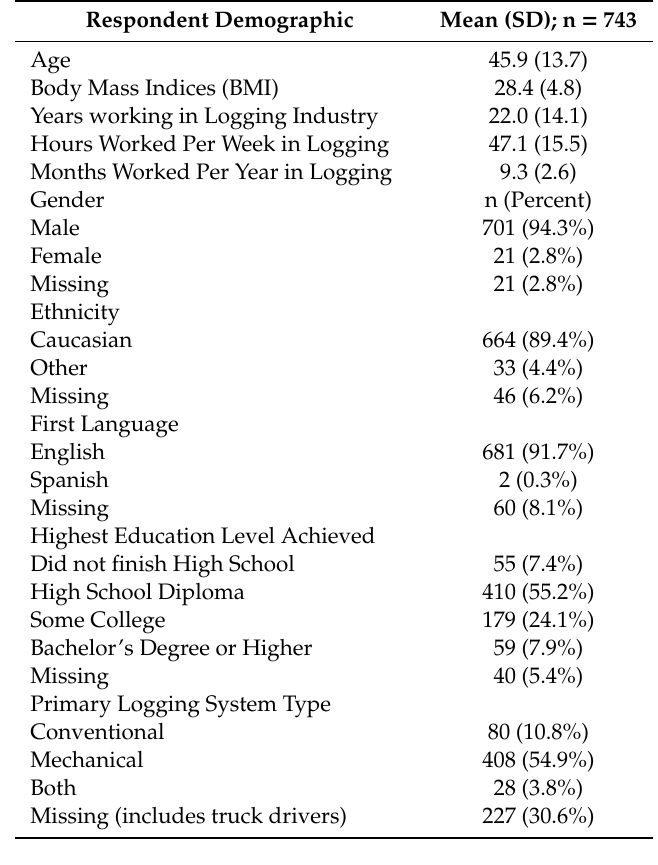
Table 1. The respondent demographics.